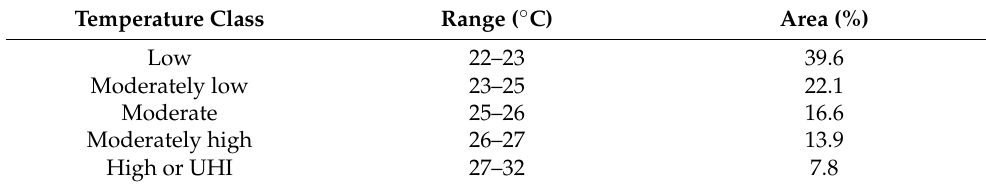
Table 4. LST classes with their range, related LULC